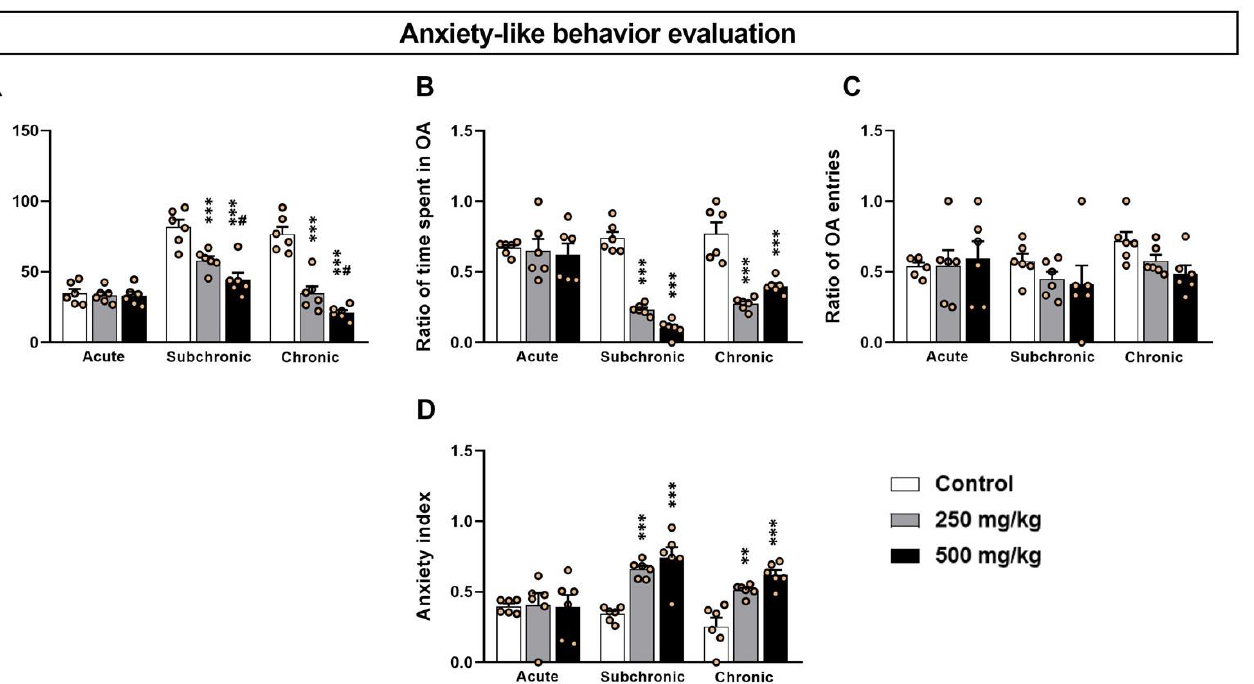
Figure 1. Effect of acute and repeated exposure to GBH on anxiety-like behavior. ( A ) Histograms showing time spent in the center of the OF, ( B ) the ratio of time spent in the open arms, ( C ) the ratio of open arm entries, and ( D ) the anxiety index. Results are presented as mean ± SEM. ** p < 0.01; *** p < 0.001; # p < 0.05. * indicates comparison between control vs. 250 mg/kg and 500 mg/kg groups; # indicates comparisons between 250 mg/kg vs. 500 mg/kg group.